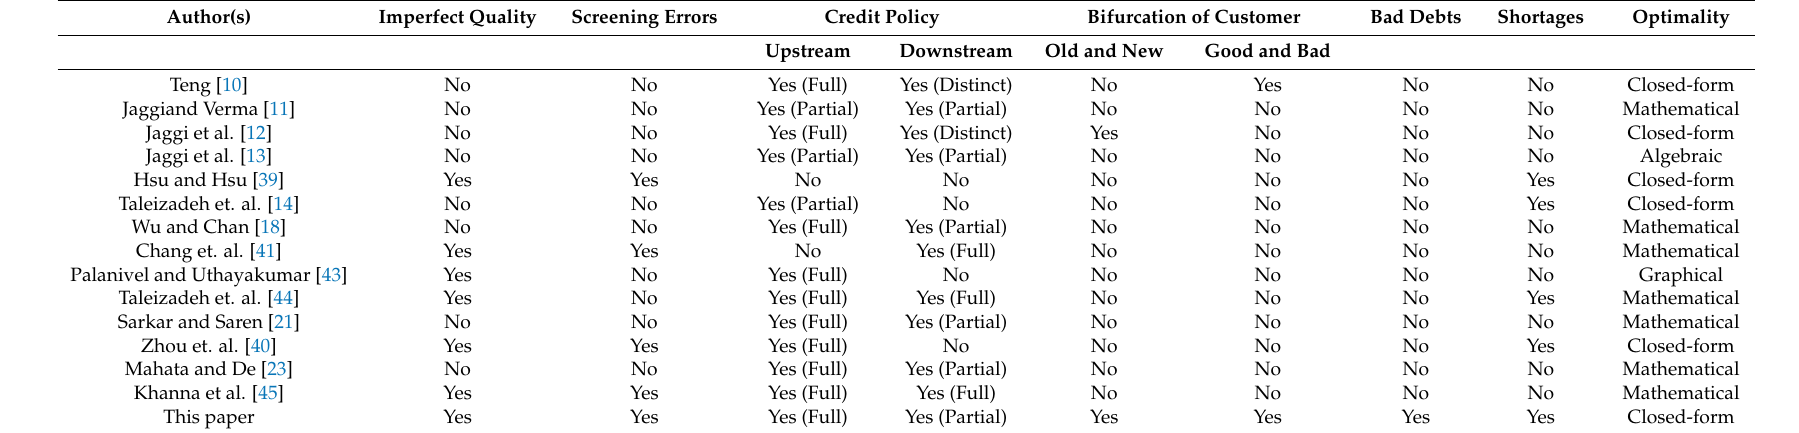
Table 1. Comparison of major attributes of some previous work with current